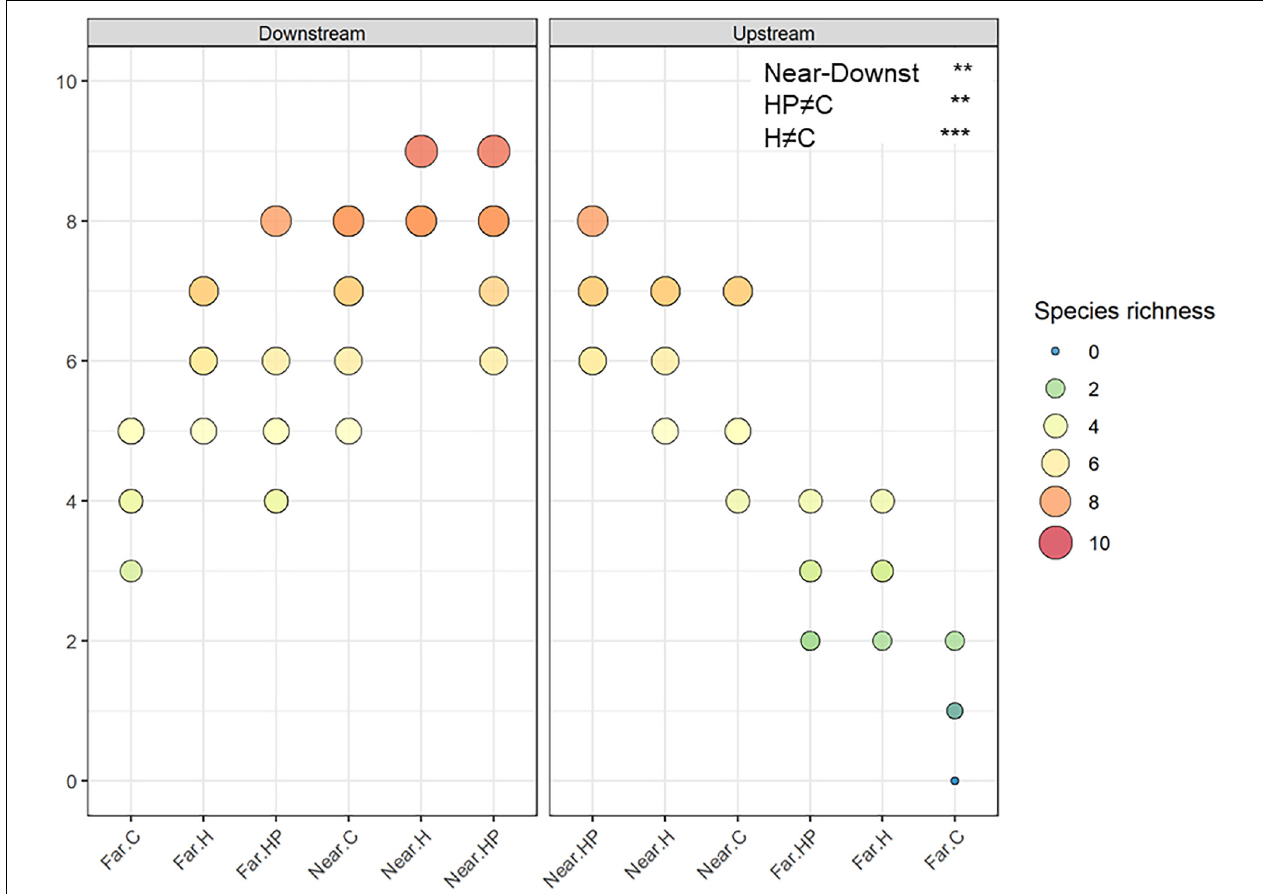
FIGURE 4 | Amphipod species richness in the different ACs containing habitat and feed pellets (HP), only habitat (H) or control (C) located near and far downstream and near and far upstream. Significant GLM results are expressed as ** p < 0.01 and *** p <